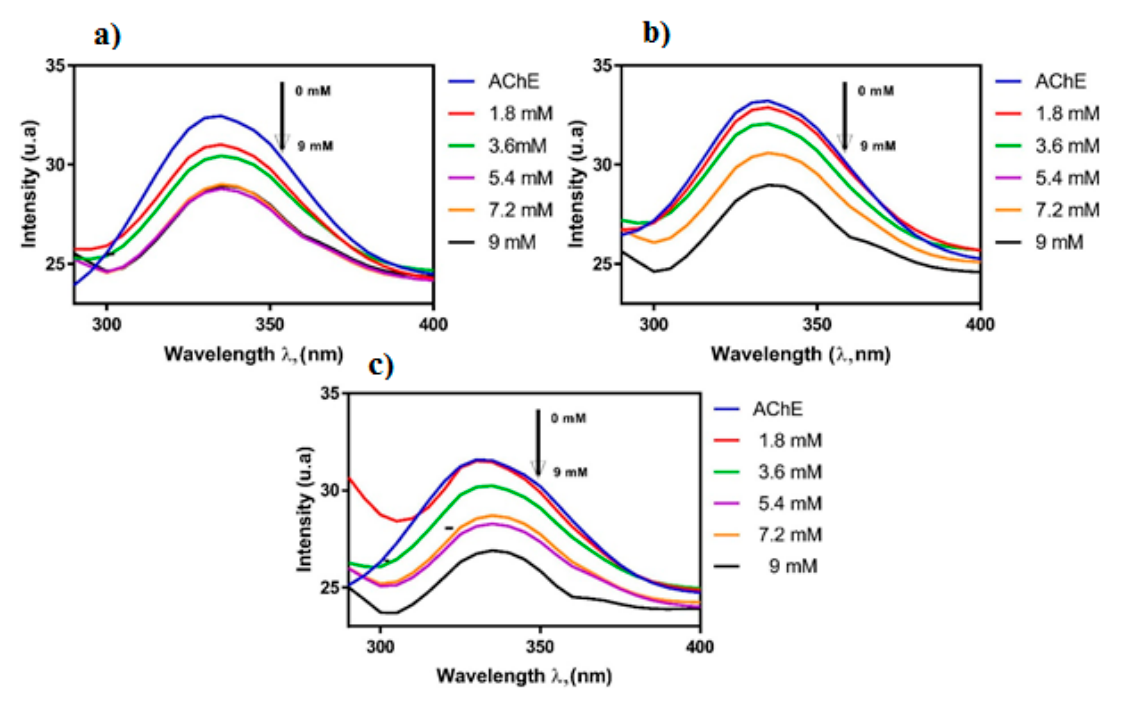
Figure 7. Fluorescence suppression spectra of AChE at 25 °C ( a ), 30 °C ( b ) and 35 °C ( c ) (kexc. = 290 nm), in 0.5 mol/L Tris-HCl buffer pH 8.0, in presence of S. guianensis essential oil. The enzyme from E. electricus was kept in a concentration of 0.67 mg/mL, and the essential oil was titrated separately missiom from Elsevier.